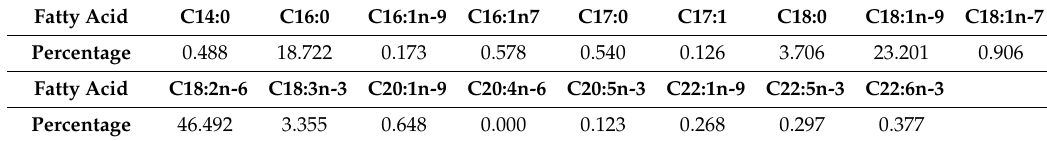
Table 1. Fatty acid composition (g / 100 g total fatty acids) of the experimental